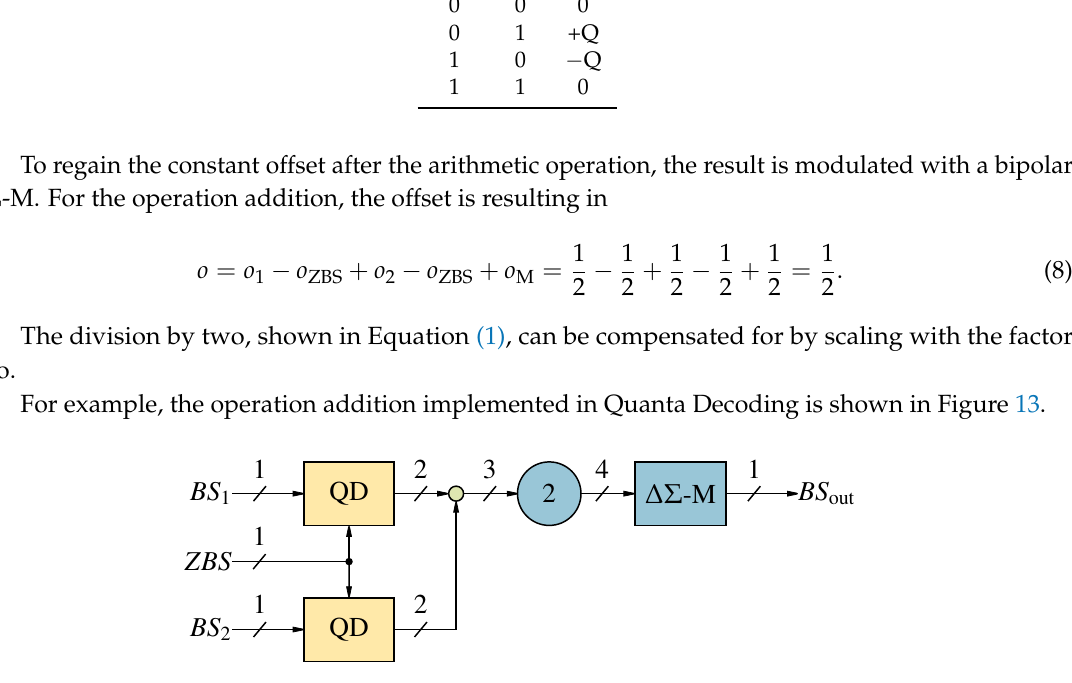
Figure 13. The ∆Σ SP operation addition performed with Quanta